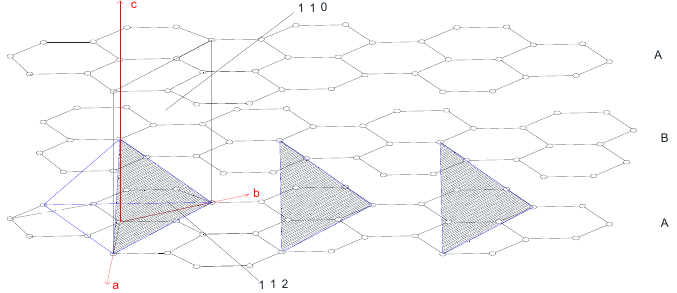
Figure 3. Graphite lattice arrangement picture.